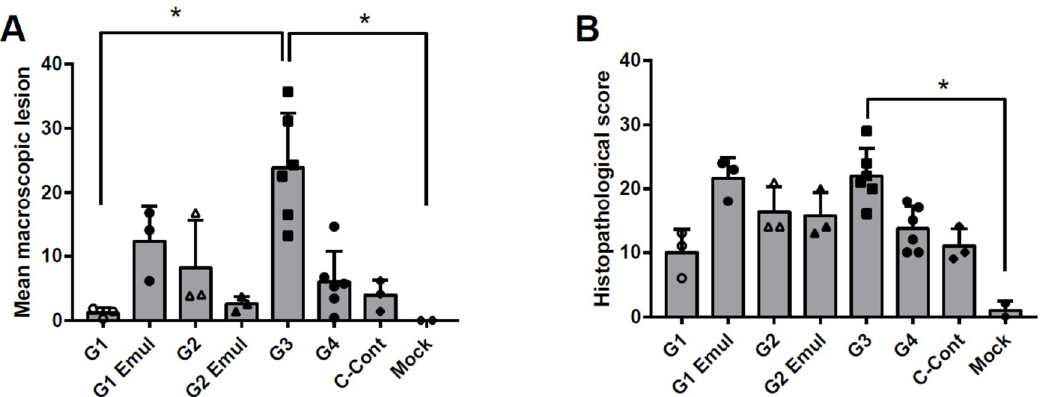
Figure 4. Macroscopic lung lesion scores and histopathology 5 dpc. ( A ) Macroscopic lesions observed in lung tissues. Bars represent means of macroscopic lung lesion scores observed on different tissues of the respiratory tract as described in the text. Error bars represent standard deviations. ( B ) Histopathology scores observed in lung tissues. Bars represent means and error bars represent standard deviations. Open and filled symbols ( △ , □ and ○ ) were used to show individual data points for the different experimental groups. * indicates statistical significant differences between the tested groups ( p < 0.05) as measured by Dunn’s multiple comparisons test performed after a Kruskal-Wallis test.